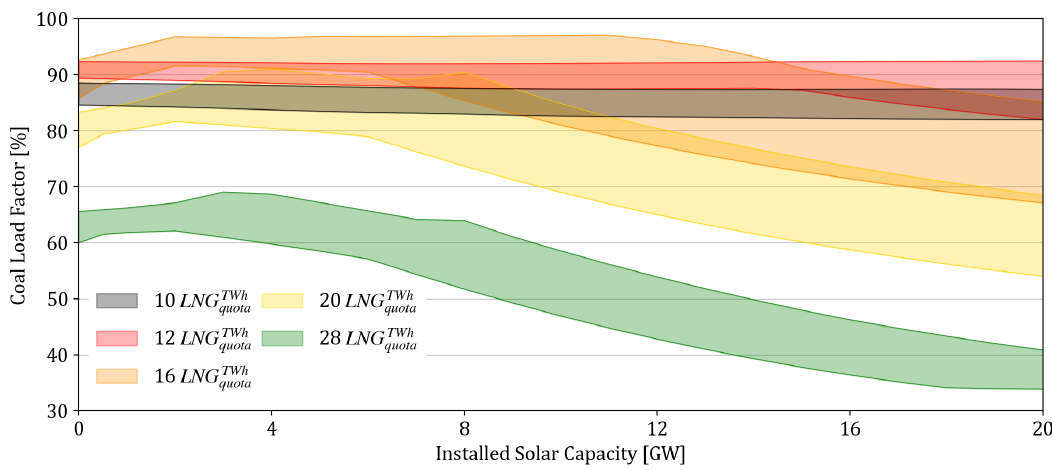
Figure 14. The coal load factor in different LNG quota